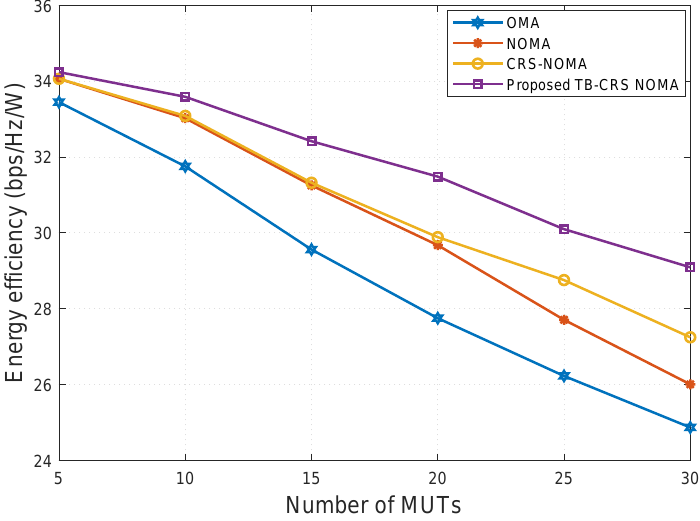
Figure 9. Energy efficiency versus the number of MUTs when SNR = 20